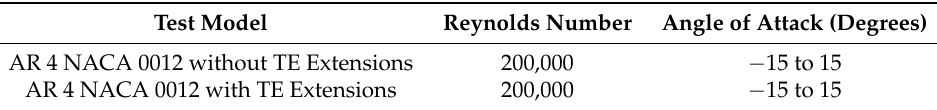
Table 1. Test Matrix for the force based